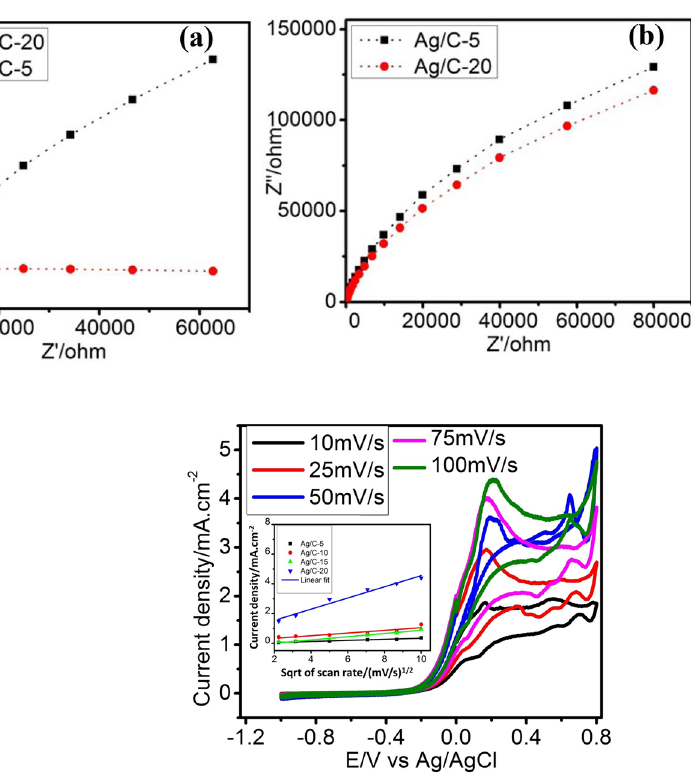
Fig. 6 CV of Ag/C-20 at 0.5 M NaOH + 0.01 M NaBH scan rates at 25 °C. Corresponding plot of maximum forward peak currents versus square root of scan rates for all Ag/C catalysts are shown in